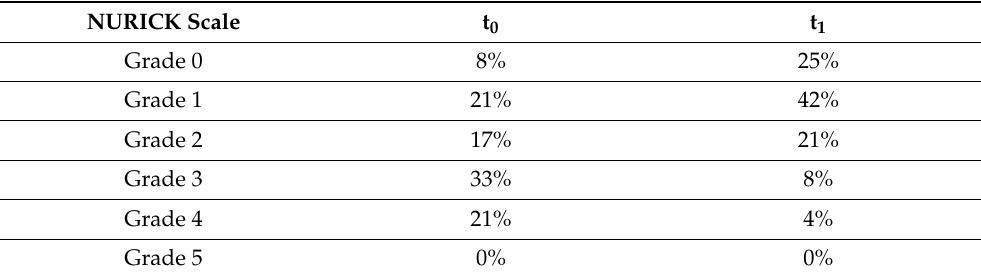
Table 3. Distribution of patients according to their Nurick score classification at t 0 and t 1